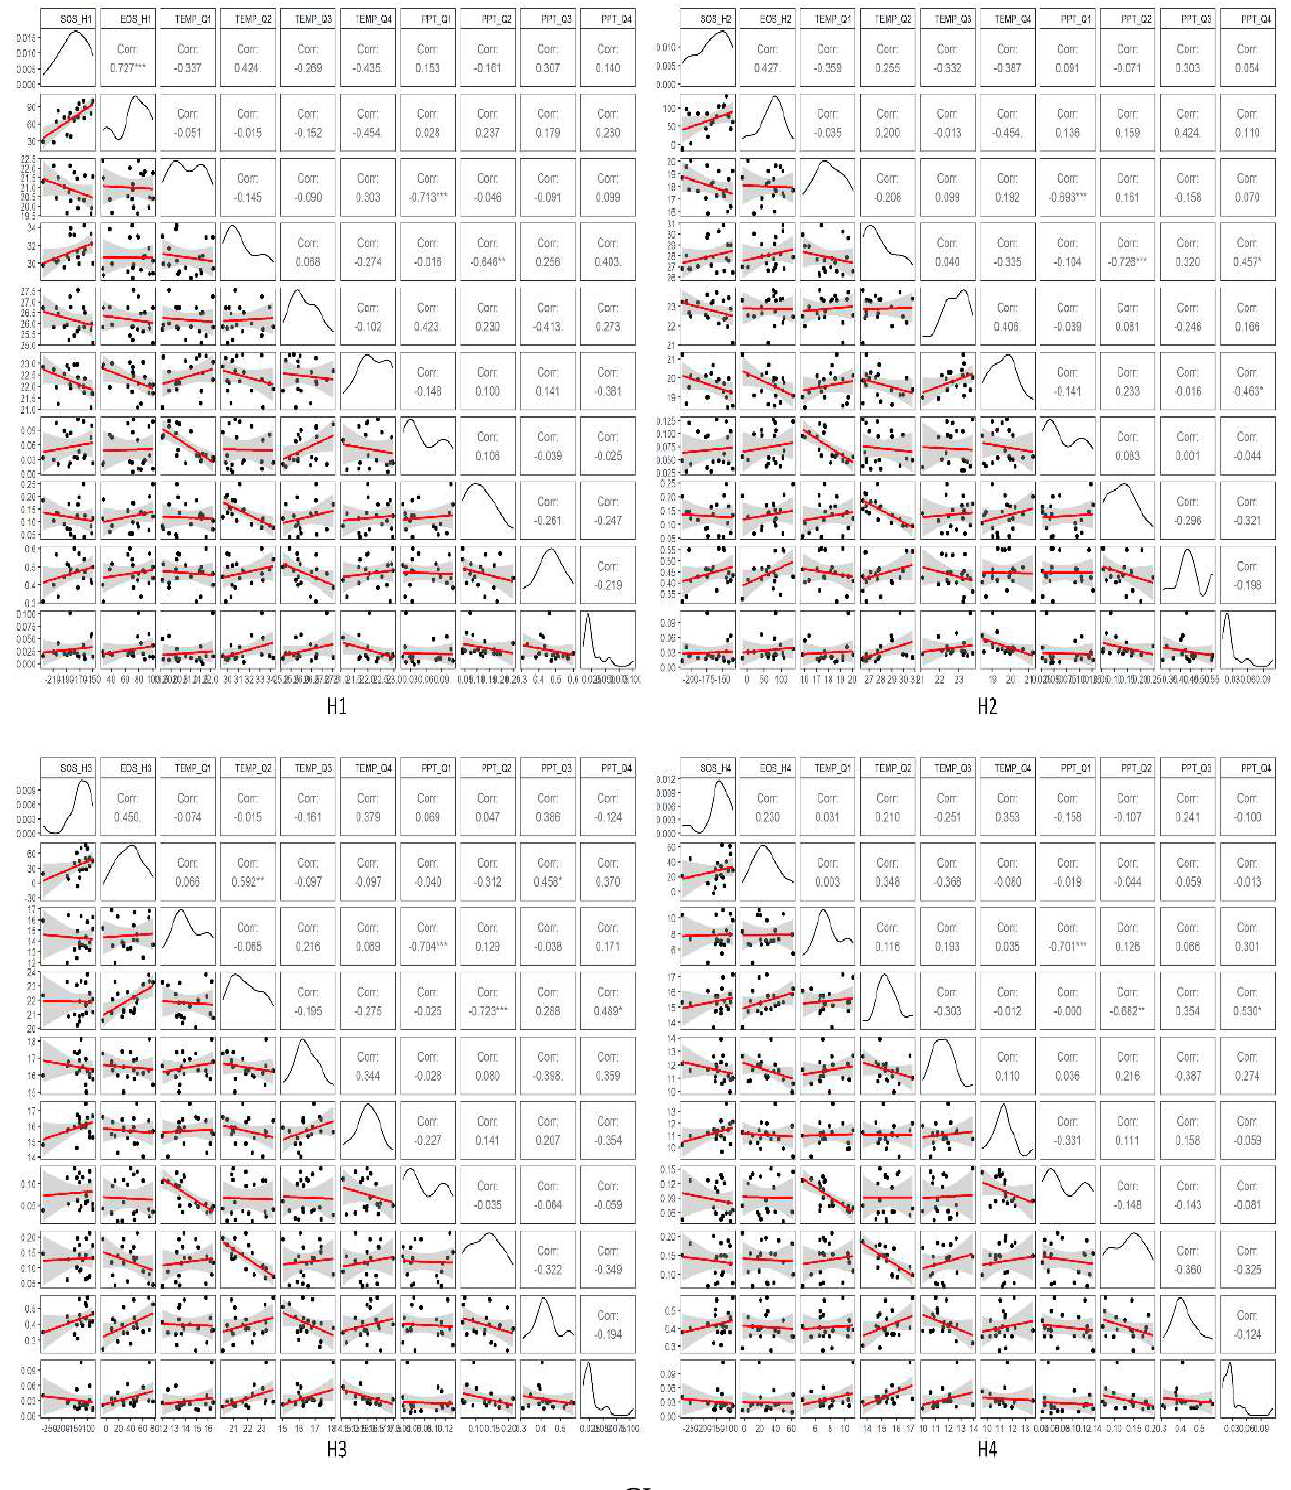
Figure 5. Relationship between phenometrics (SOS and EOS) and climatic variables (temperature and precipitation). The upper triangle consists of correlation value (R2) with significant ( p value), and diagonal axis shows the density and lower triangle scatter plot with regression fit line. Here H1, H2, H3, and, H4 are the subzones divided along the altitudinal gradient of the vegetation types. The level of significance is depicted by asterisk (* p ≤ 0.05, ** p ≤ 0.01, and *** p ≤ 0.001).